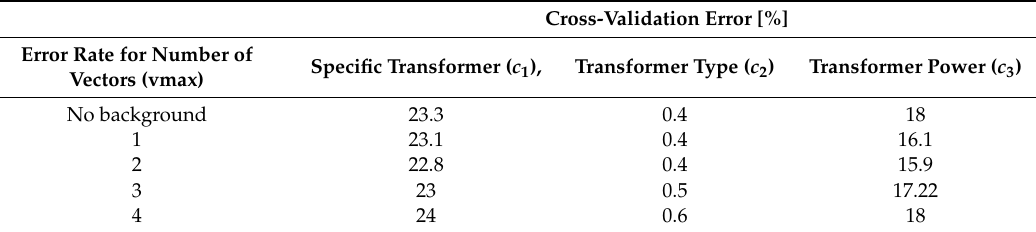
Table 2. The values were obtained using the kNN classifier. Table 2. The result of finding background representation. Table 2. The result of finding background representation.